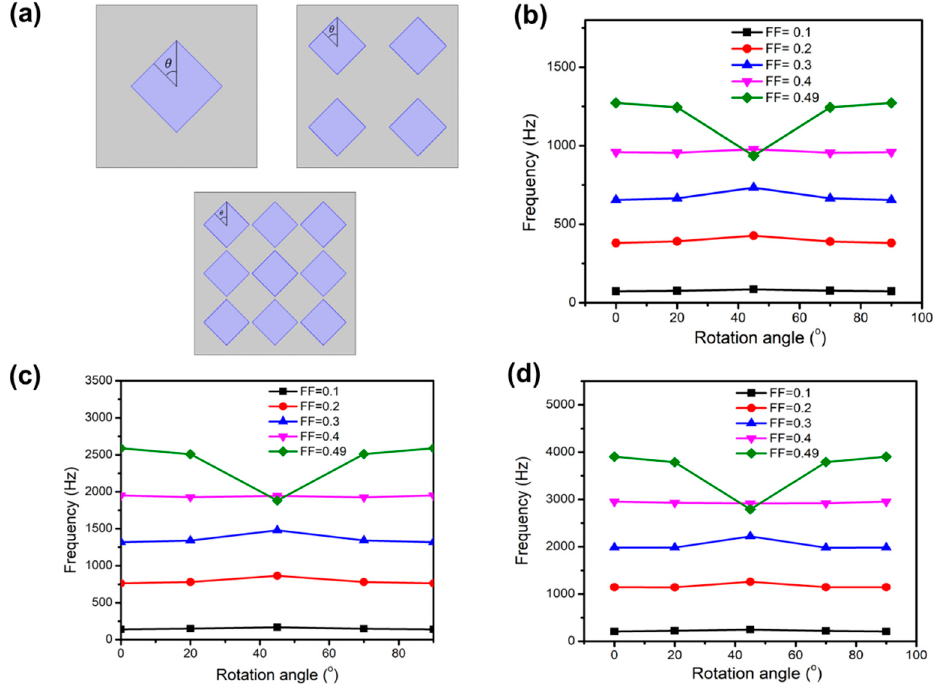
Figure 4. ( a ) Phononic crystals with square inclusions rotated by an angle of θ = 45 ◦ . ( b ) Bandwidth versus rotation angle of composites with filling fractions of 0.1–0.5, for one- ( b ), four- ( c ), and nine-square ( d ) inclusions within the host.